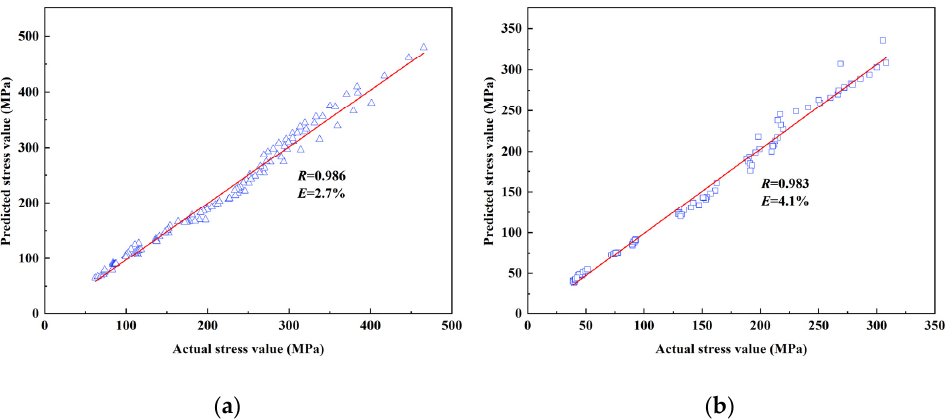
Figure 10. Correlation analysis between the actual stress values and predicted stress values at different phase fields: ( a ) α + β and ( b ) β .